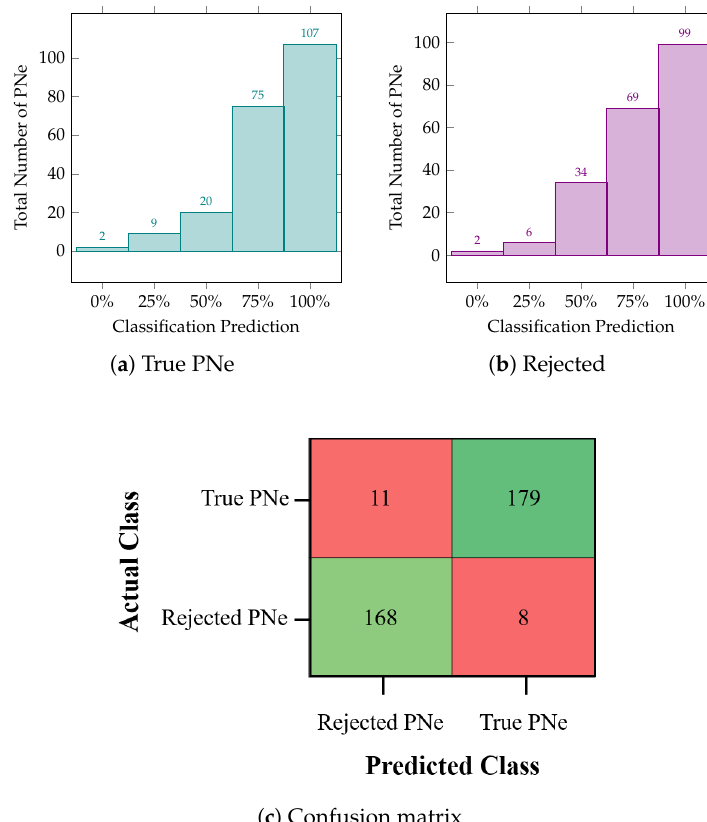
Figure 8. Combined predictions for True PNe and Rejected class using the DenseNet201 DTL model: ( a ) probability distribution histogram for True PNe prediction; ( b ) probability distribution histogram for Rejected prediction; and ( c ) confusion matrix of the combined predictions derived from ( a , b